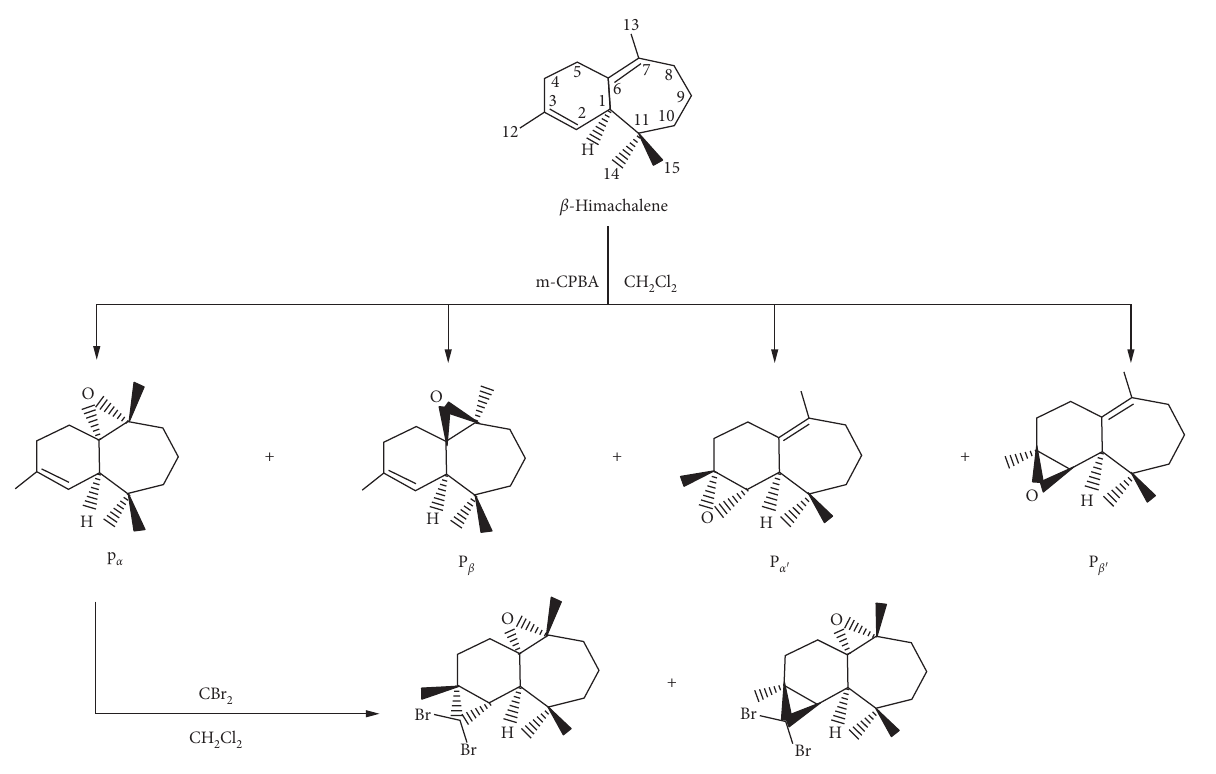
Figure 1: Addition scheme reactions of m-CPBA and dibromocarbene to β